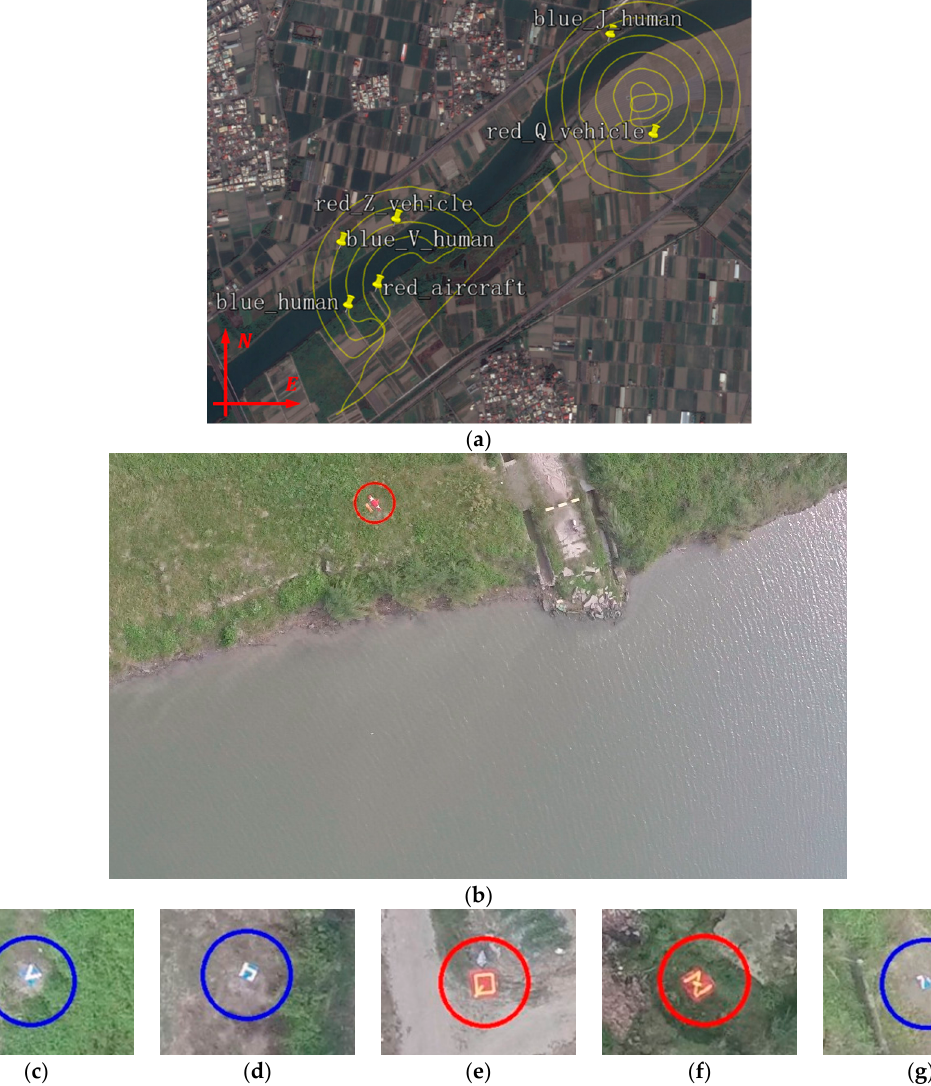
Figure 21. ( a ) The locations of six simulated targets; ( b ) the original image saved by the identification program with target drone; ( c ) designed target (blue board with letter V) represents an injured person; ( d ) designed target (blue board with letter J) represents an injured person; ( e ) designed target (red board with letter Q) represents a crashed car; ( f ) designed target (red board with letter Z) represents a crashed car and ( g ) designed target (small blue board) represents an injured person. The board was blown over by the wind.